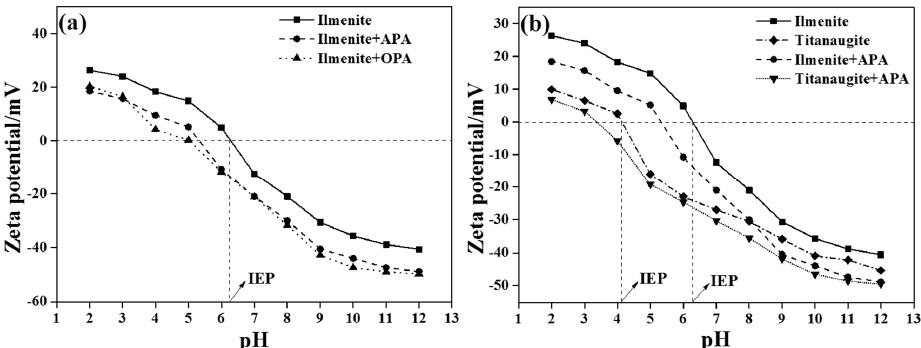
Figure 6. Zeta potentials of ilmenite ( a ) and titanaugite ( b ) as a function of pH.